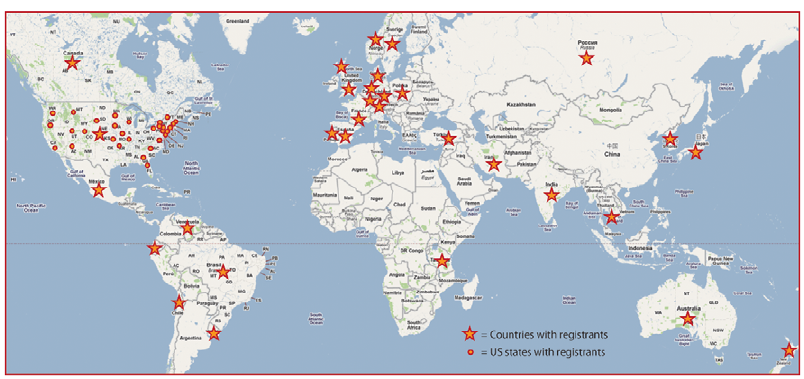
Figure 1. Over 560 people from 31 US states and 30 other countries registered for the November 2010 workshop. (Red dots represent the US states with WWW registrants; red stars represent the countries with WWW registrants) [7].